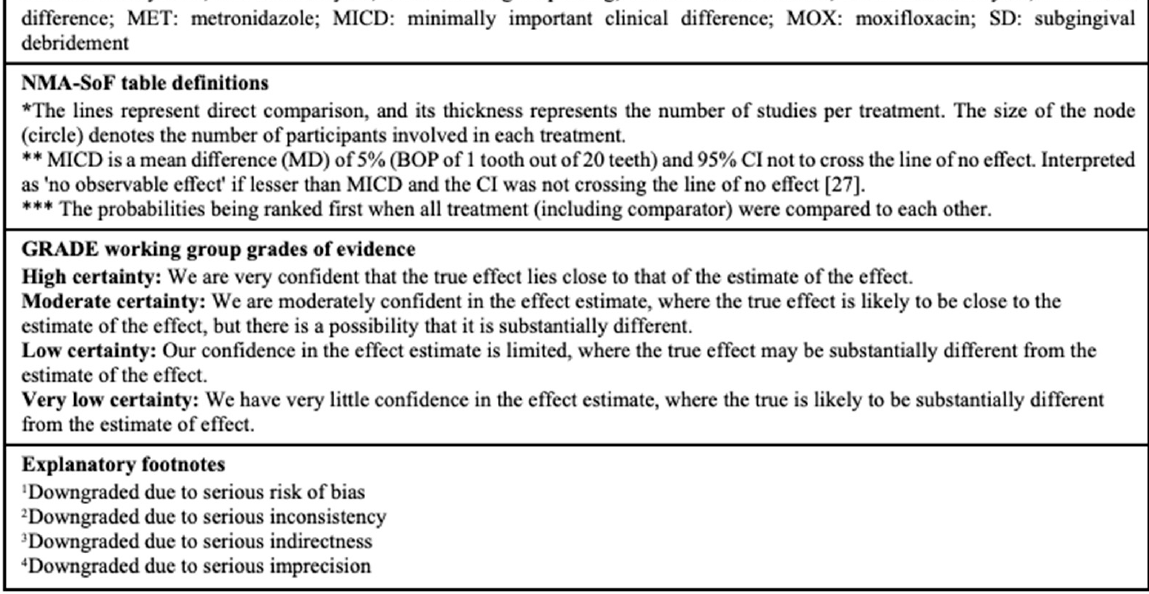
Figure 12. Summary of findings for short-term BOP reduction following the use of systemic antibiotics adjunctive to subgingival debridement.